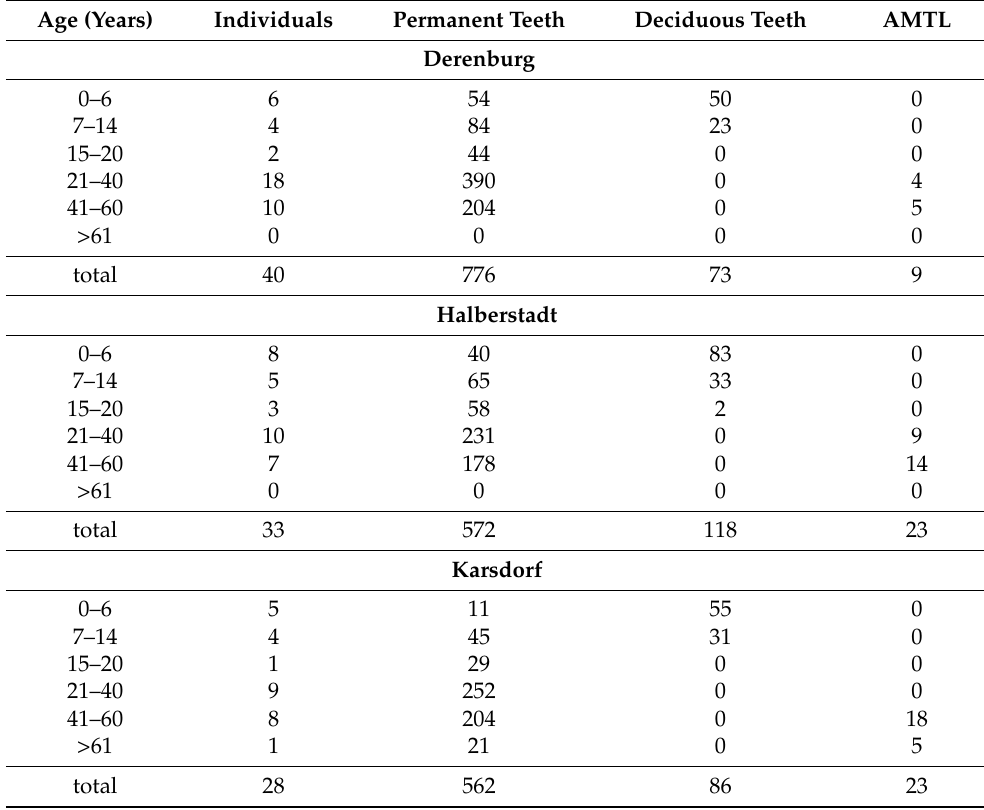
Table A1. Number of individuals, permanent teeth, deciduous teeth and teeth lost ante-mortem (AMTL) of the three burial sites by age